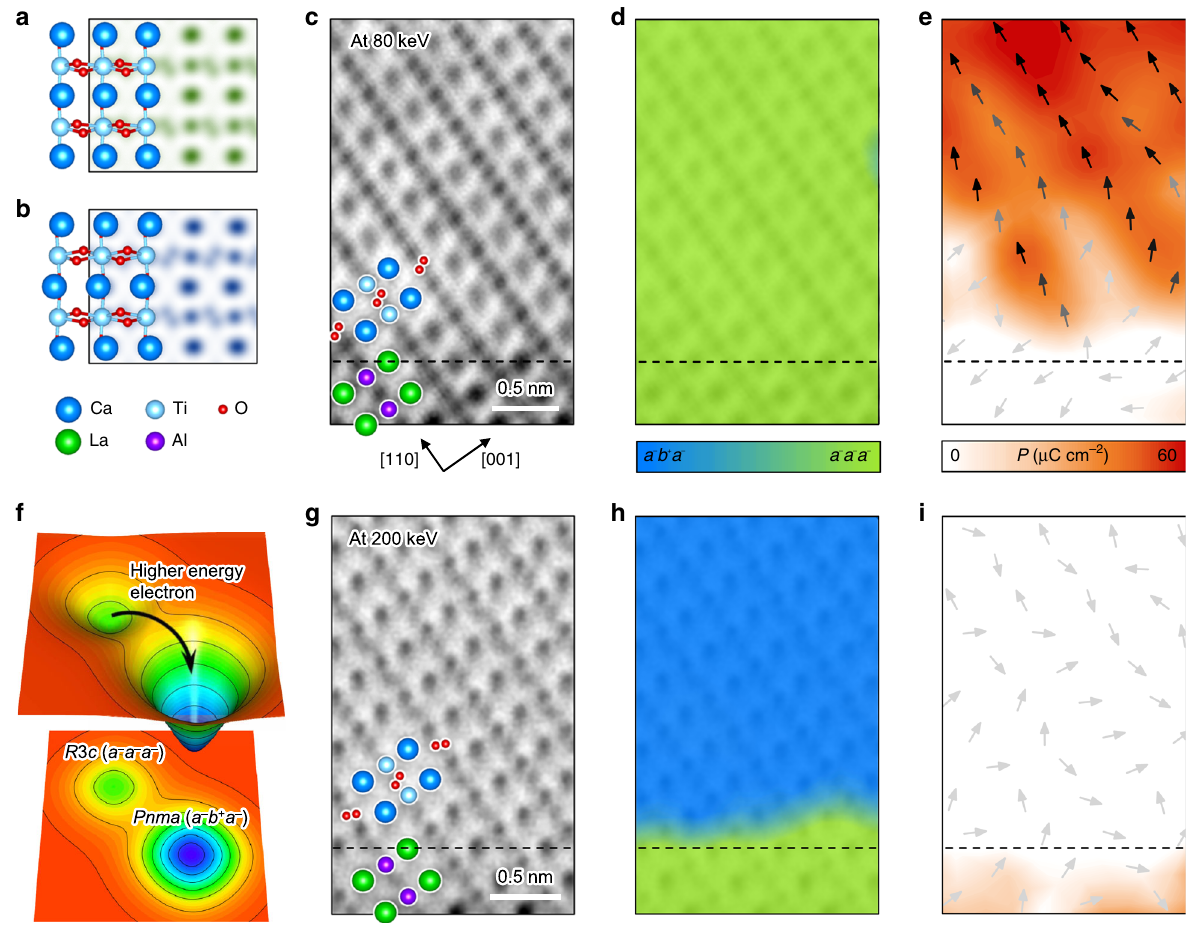
Fig. 3 Atomic-scale analysis of the OOR pattern and polarity in CaTiO 3 fi lms. Simulated annular bright- fi eld scanning transmission electron microscopy (ABF-STEM) images along the zone axis of [1 (cid:1) 10] for a − a − a − ( a ) and [101] for a − b + a − ( b ) OOR patterns. c – i ( c ) and ( g ) show ABF-STEM images of 2.6 nm-thick CaTiO 3 (111) fi lm along the zone axis of [1 (cid:1) 10], measured using 80-keV ( c ) and 200-keV ( g ) electron kinetic energy. d , h display the maps of OOR patterns, identi fi ed by deep neural network analysis, in the same regions as in ( c ) and ( g ), respectively. Color indicates the probability of each OOR pattern. e , i present polarization vectors for each unit cell of the same regions as in ( c ) and ( g ), respectively. Arrows denote the polarization direction; the stronger the polarization, the darker the arrow color. Strength of polarization is also expressed as a color map, ranging from white (weak) to red (strong). f illustrates a schematic free energy landscape, showing the relaxation of R 3 c state ( a − a − a − ) into Pnma state ( a − b + a −